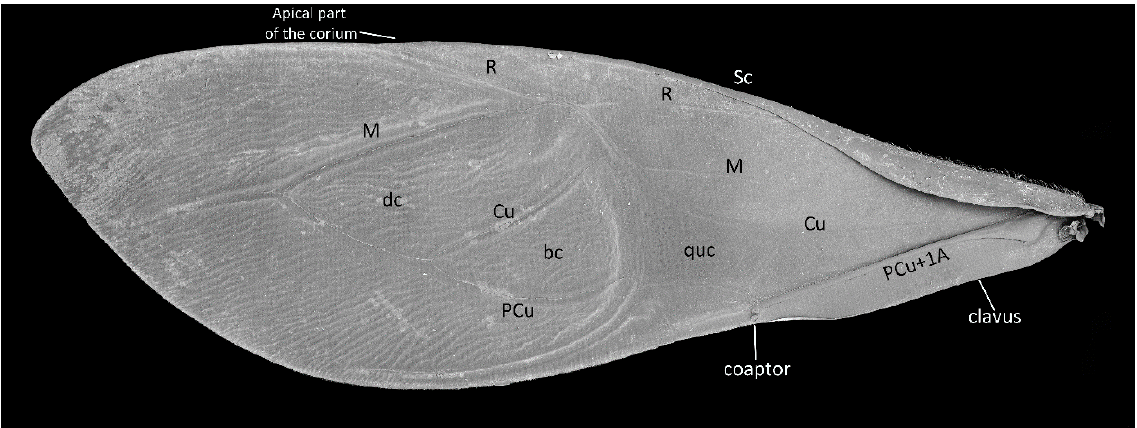
Figure 17. Phonoctonus bifasciatus Villiers, 1948: ( A ) anterior and posterior lobe of pronotum with humeri marked with *. P. fasciatus (Beauvois, 1805): ( B ) magnification of the bunches of sensilla at the underside of the posterior pronotal lobe using secondary electron detector (SED); view of the mentioned bunches of sensilla ( C ) on the right and ( D ) on the left side of the pronotum.